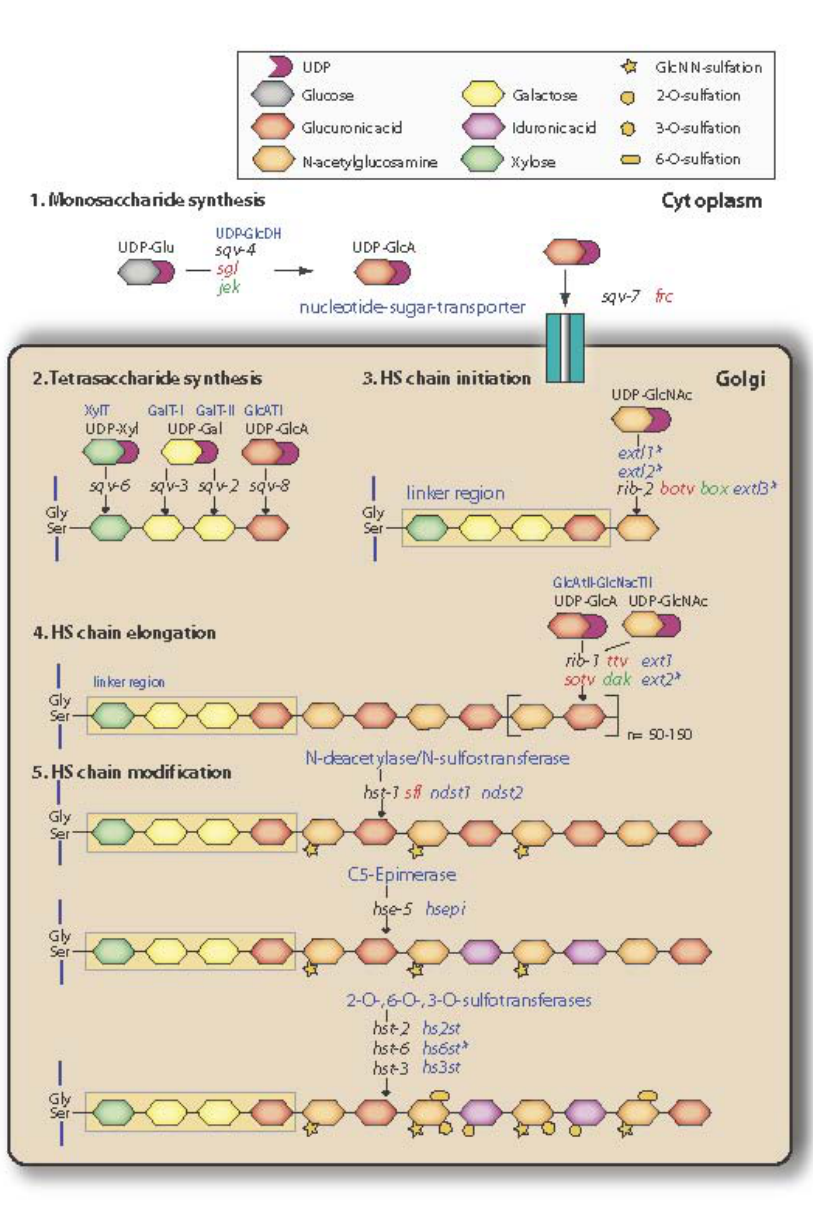
FIGURE 2. HS synthesis and modification. HS synthesis starts in the cytoplasm with the synthesis of monosaccharides, which are subsequently transported into the Golgi where they are incorporated into a conserved tetrassaccharide linker. HS polymerases catalyze the addition of glucuronic acid and N-acetyl glucosamine to the linker to form the HS sugar backbone. This backbone is later modified by a C5-epimerase and various sulfotransferases giving rise to complex modification patterns. Mutants for enzymes involved in HS synthesis and modification are shown in black ( C. elegans ), red ( Drosophila ), green (zebrafish), and blue (mouse). Enzymes are abbreviated as follows: GalTI, galactosyltransferase I; GalTII, galactosyltransferase II; GlcATI, glucuronyltransferase I; GlcATII, glucuronyltransferase II; GlcNACTI, N-acetylglucosamine transferase I; GlcNAcTII, N-acetylglucosamine transferase II; NDST, N-deacetylase/N-sulfotransferase; UDP-GlcDH, UDP-glucose dehydrogenase; XylT, xylosyltransferase. botv , brother of tout velu ; box , boxer ; dak , dackel ; ext, exostosin; extl, exostosin-like; frc , fringe connection ; jek , jekyll ; sfl , sulfateless ; sgl , sugarless ; sotv , sister of tout velu ; sqv , squashed vulva ; ttv , tout velu . * No mouse knock-out available